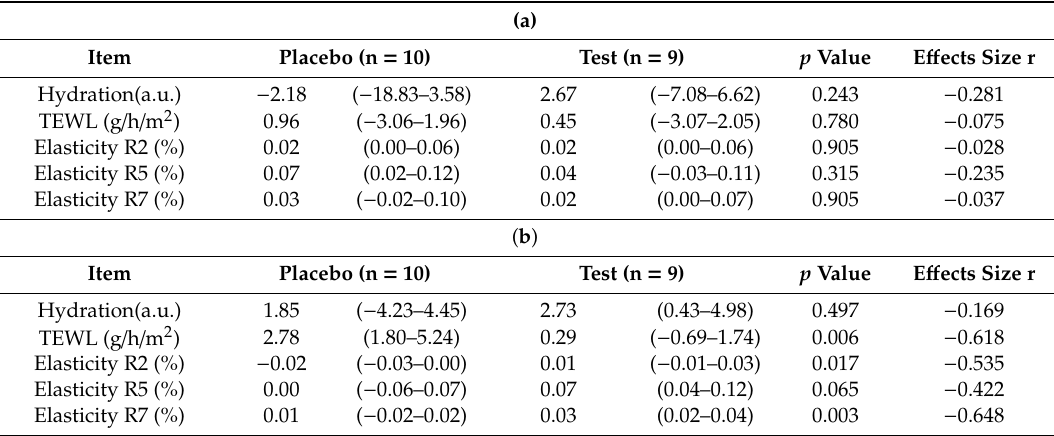
Table 4. ( a ) Comparison of changes of cheek skin values between the placebo group and test group. ( b ) Comparison of changes of arm skin values between the placebo group and test